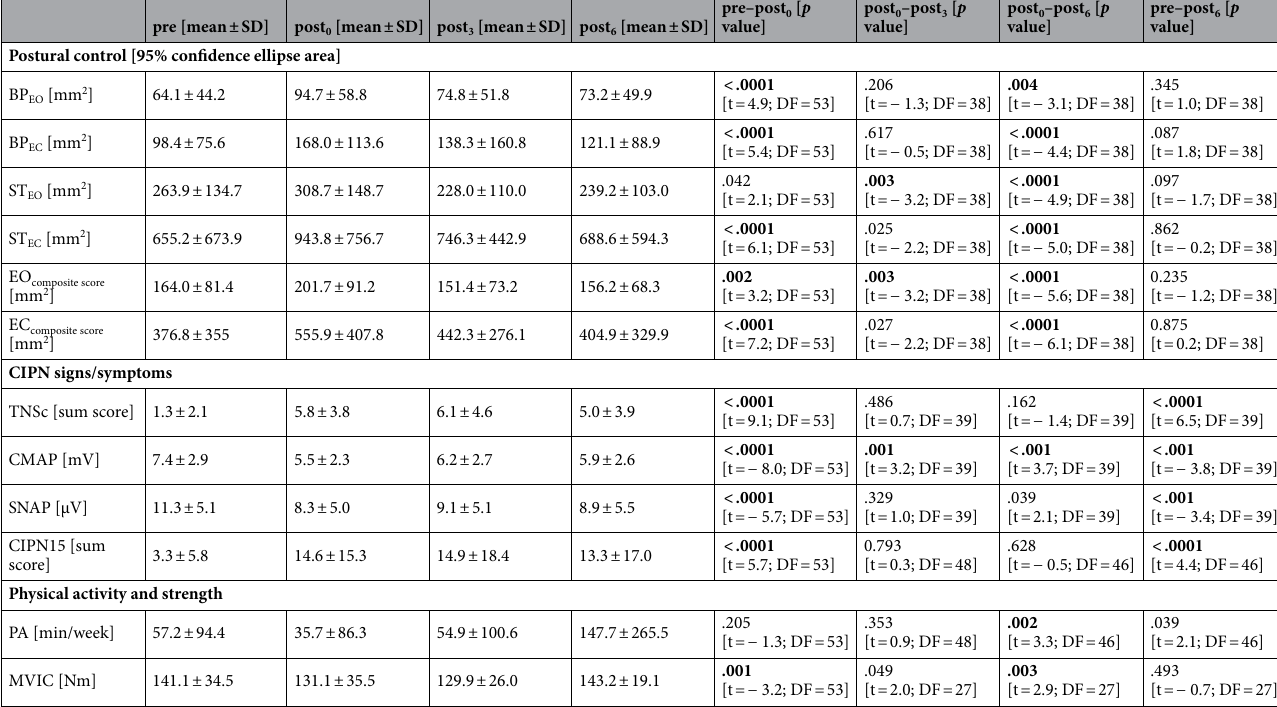
Table 2. Descriptive statistics and results of paired t-tests. Descriptive statistics are shown for each assessment point separately (mean and standard deviation) and p -, t-values and DF as revealed by paired t-tests. Bold p values are considered statistically significant ( p < .0125). BP, bipedal stance; CIPN15, sum score based on EORTC QLQ-CIPN20 questionnaire; CMAP, compound muscle action potential of peroneal nerve; DF, degrees of freedom (paired t-test); EC, eyes closed; EO, eyes open; MVIC, maximal voluntary isometric contraction; PA, physical activity; pre, assessment point before neurotoxic chemotherapy; post 0 , assessment point 3 weeks after neurotoxic chemotherapy; post 3 , assessment point three months after post; post 6 , assessment point six months after post; SD, standard deviation; SNAP, sensory nerve action potential of sural nerve; ST, semi-tandem stance; t, t-value (paired t-test); TNSc, total neuropathy score